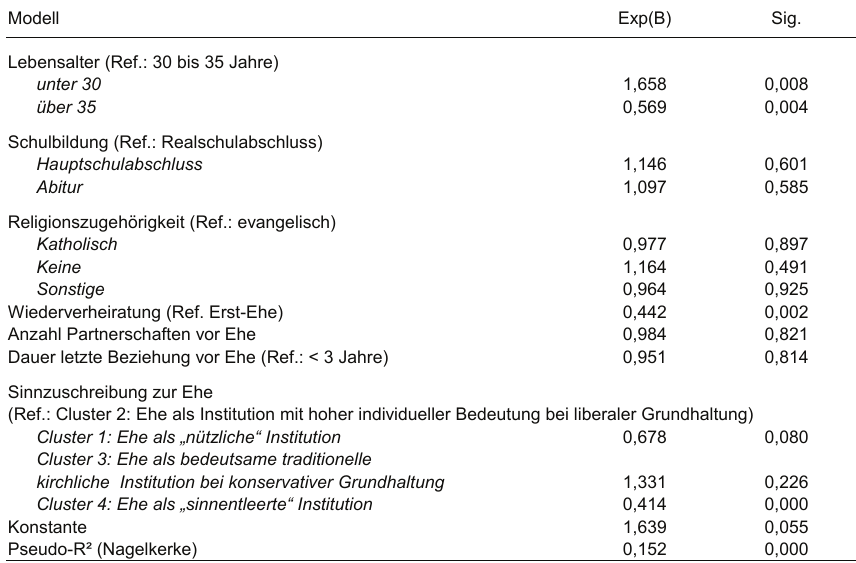
Tab. 5: Faktoren der Verlobung vor der Eheschließung Modell Exp(B)